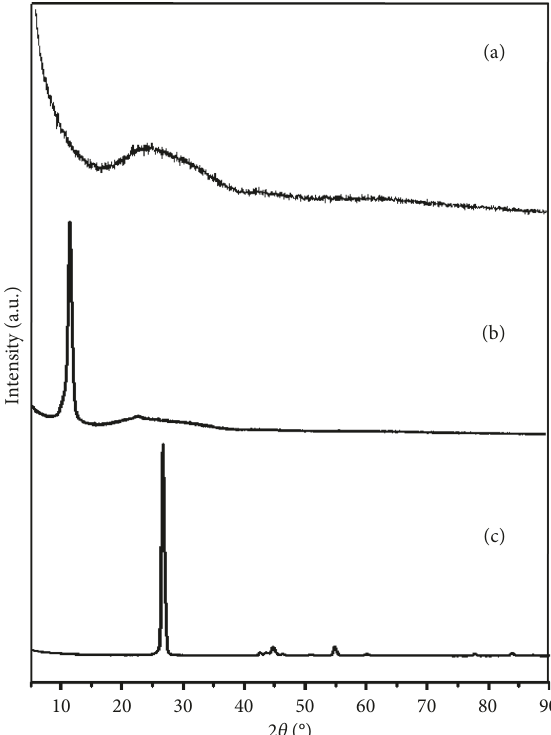
Figure 3: XRD patterns of rGO (a), graphite oxide (b), and graphite (c).